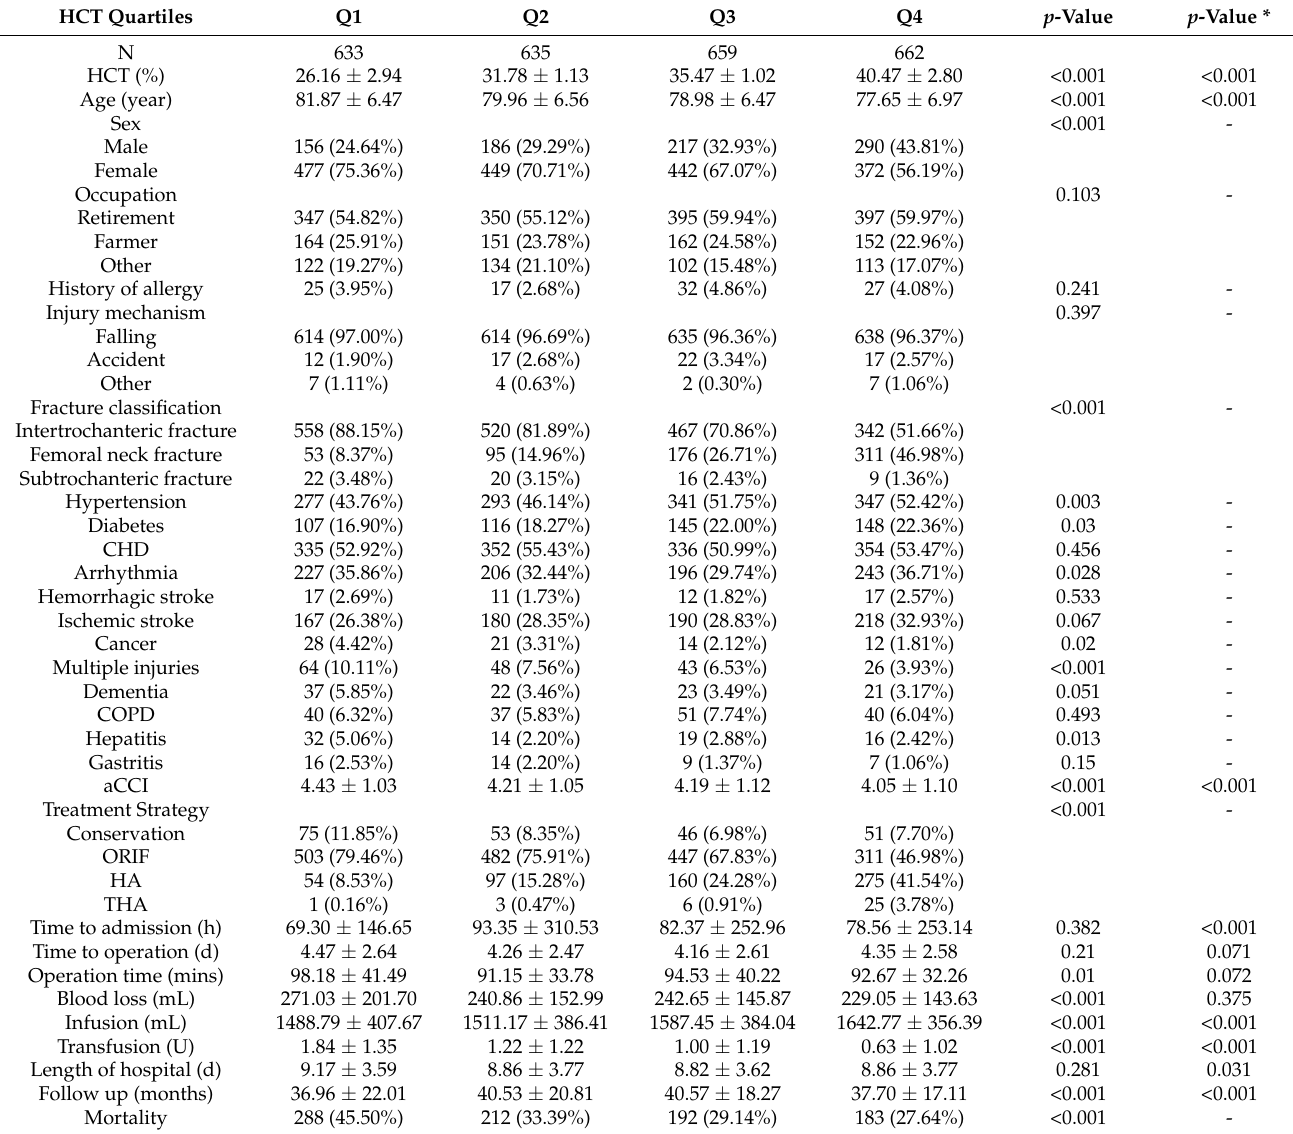
Table 1. The Demographic and clinical characteristics (N =